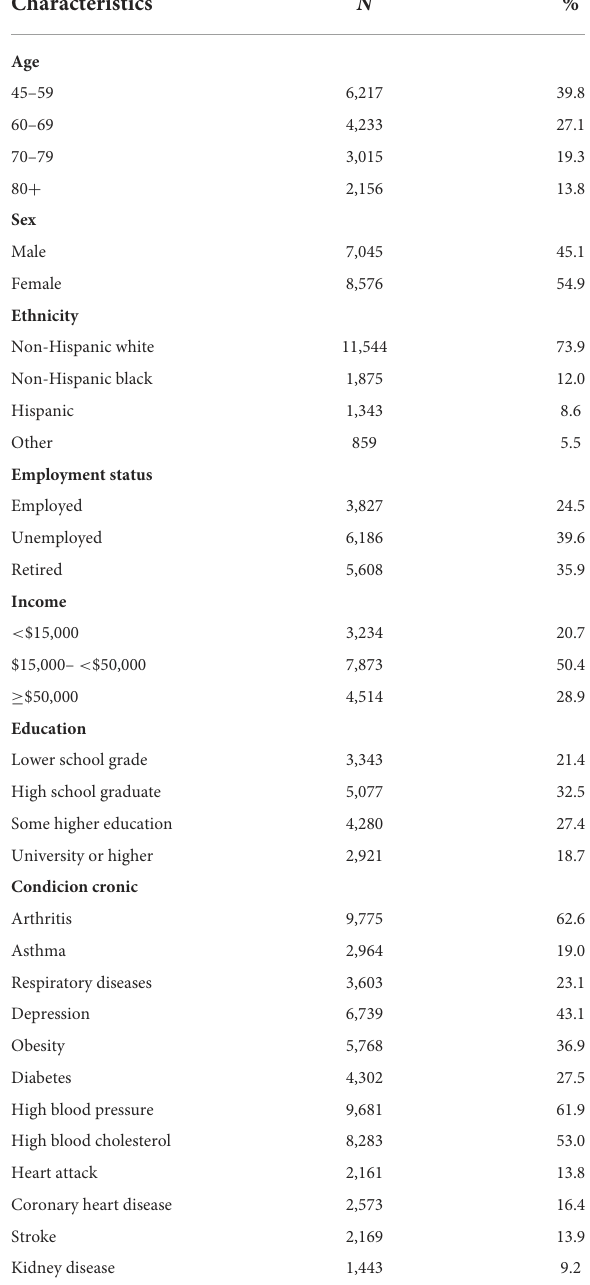
TABLE 1 Sociodemographic characteristics and chronic conditions of the participants of the participants ( n = 15,621).